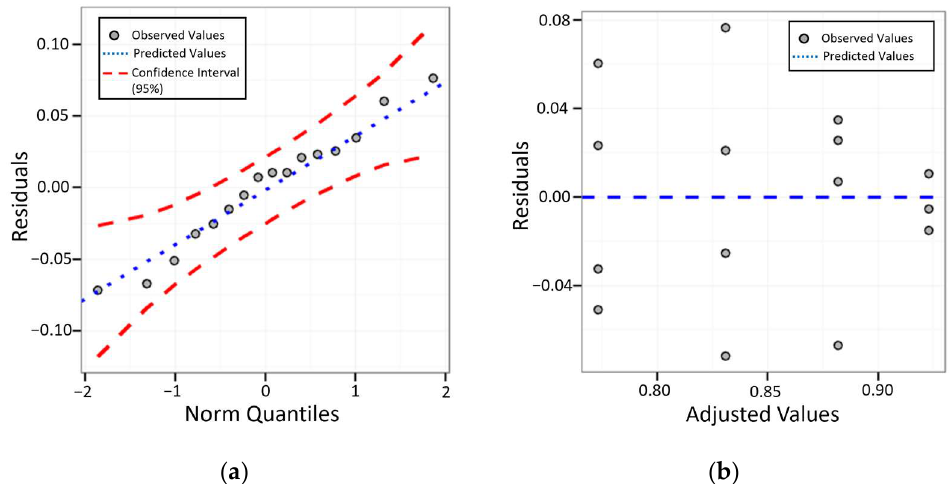
Figure 13. Residue analysis. ( a ) Comparison diagram of normal quantiles for model residuals; ( b ) Graph of residuals versus adjusted values.